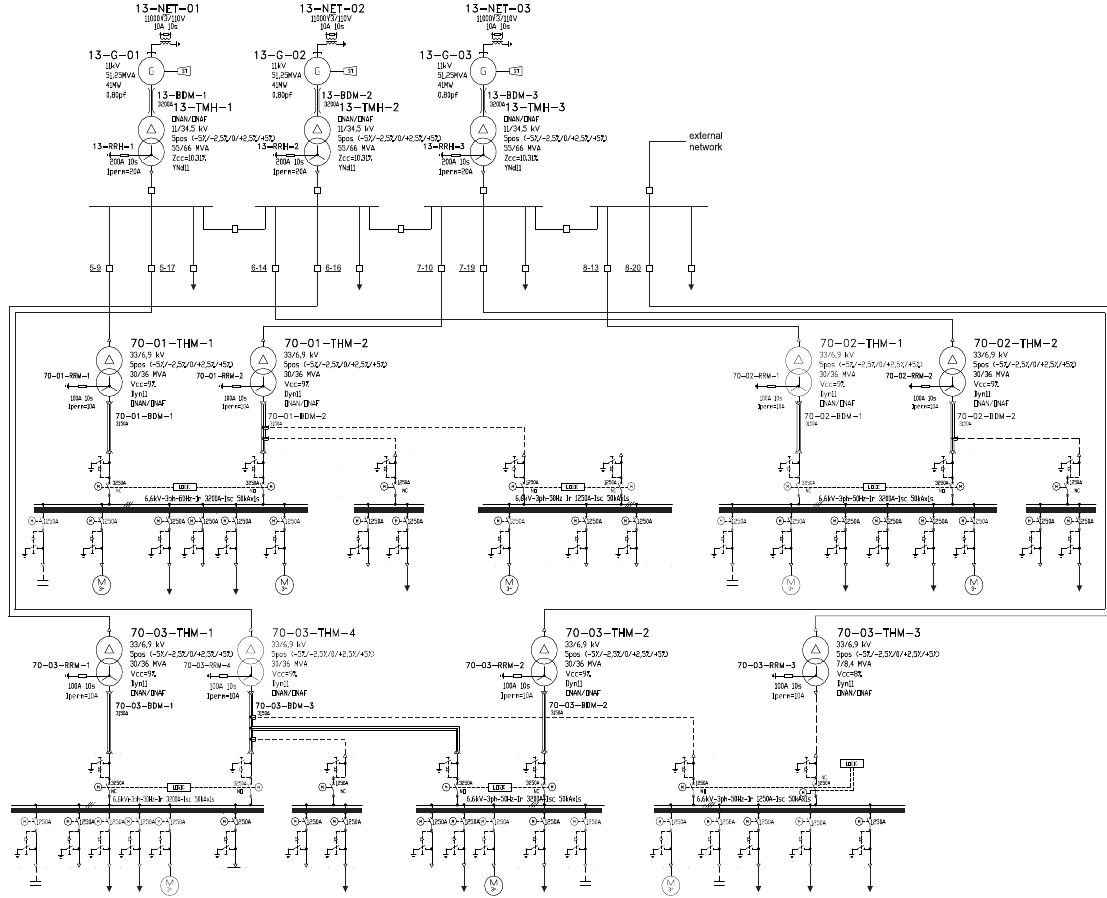
Figure 7. One-line diagram of the considered industrial